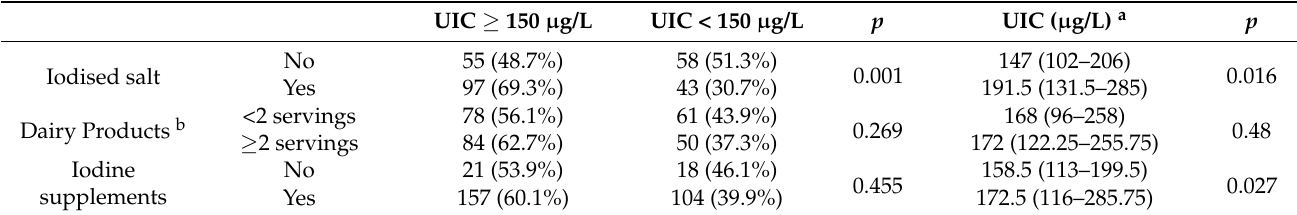
Table 1. Results of iodine consumption questionnaire showing number of women with iodine sufficiency (UIC ≥ 150 µ g/L) or insufficiency (UIC < 150 µ g/L) as well as median urinary iodine concentration for each group.